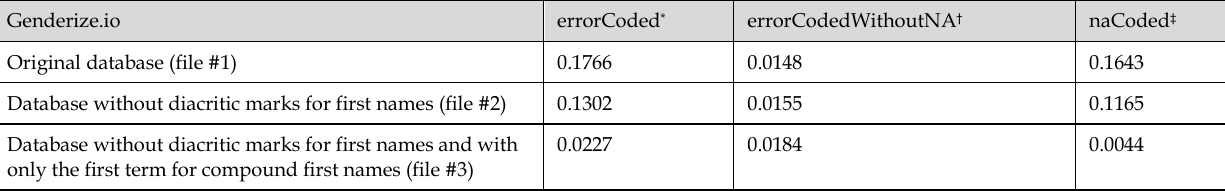
Table 2 Performance metrics for genderize.io (n=6,131 physicians)